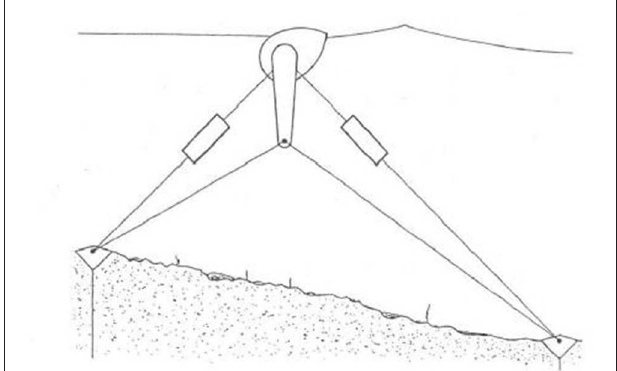
FIGURE 3 | A Solo Duck.